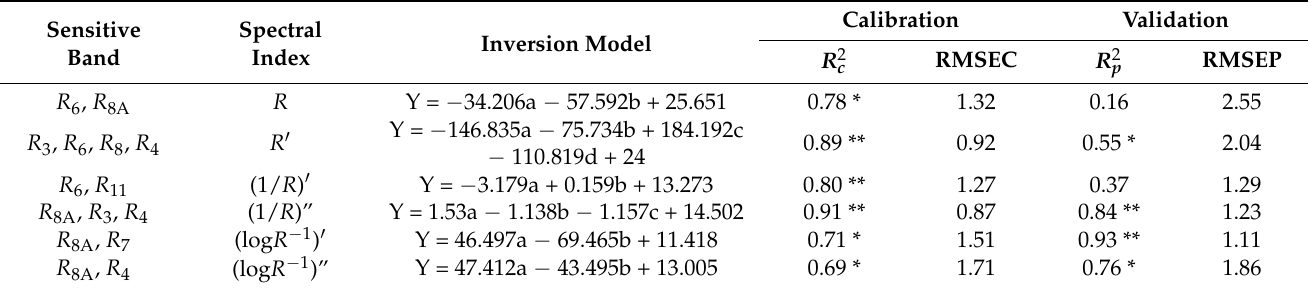
Table 7. Multi-band inversion model of soil organic matter content based on spectral